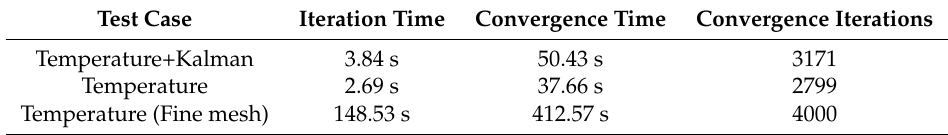
Table 7. Comparison between the run times for the segregated method and the integrated